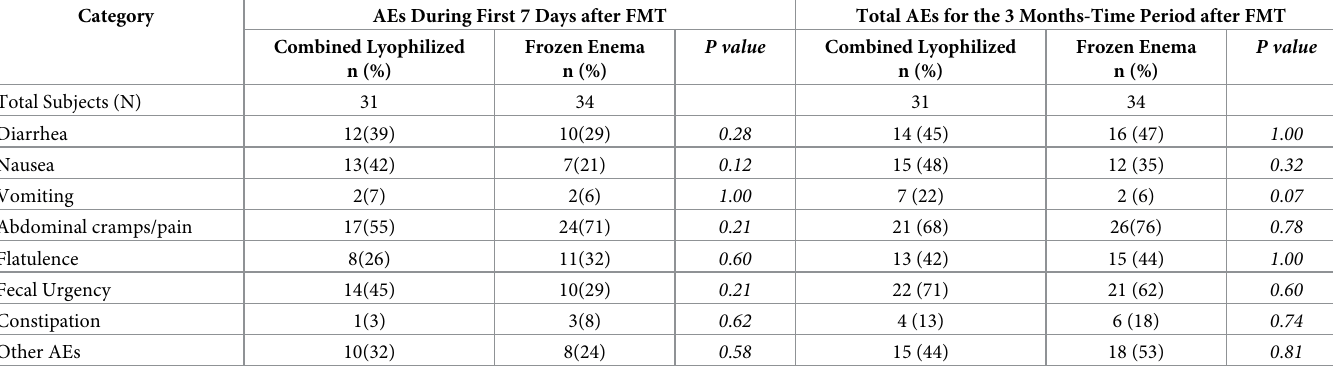
Table 2. Subject-reported Adverse Experiences (AEs) by treatment group.